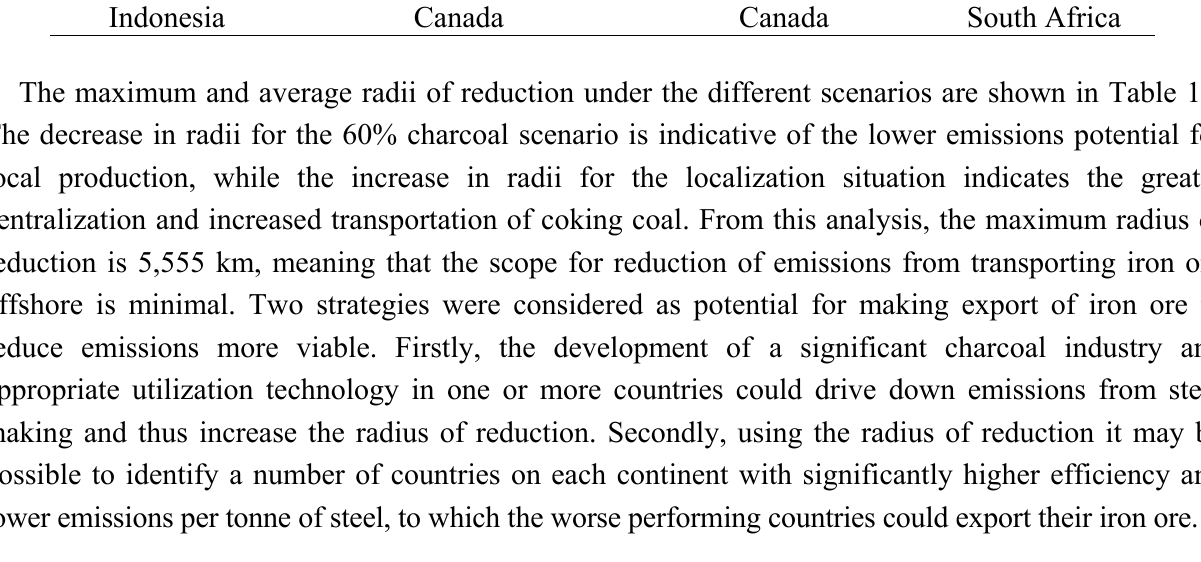
Table 10. Radii of reduction measures under different